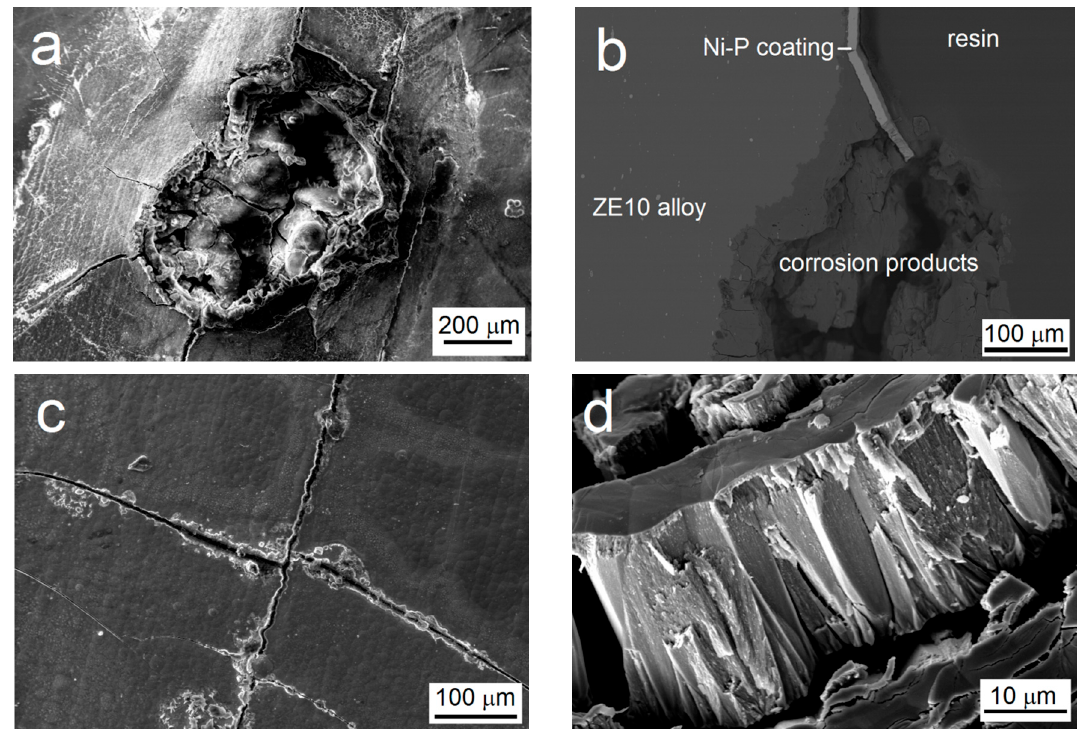
Figure 7. Corrosion degradation of the Ni–P coating on the ZE10 magnesium alloy: ( a ) surface, ( b ) cross-section, ( c ) cracks in Ni–P coating caused by the increase in volume under deposited coating due to the corrosion, ( d ) cracked Ni–P coating.